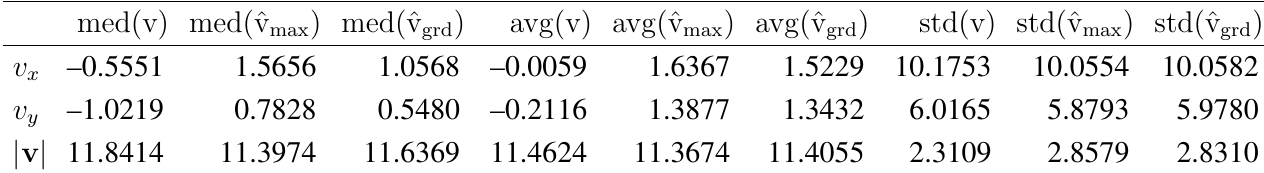
Table 2. Summary statistics for SM processing averaged over all 45 orbiting cloud